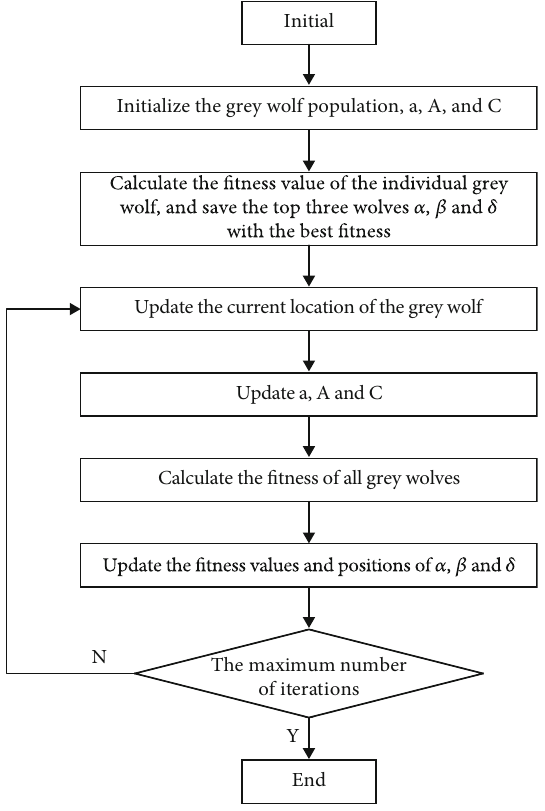
Figure 1: Flow chart of the grey wolf